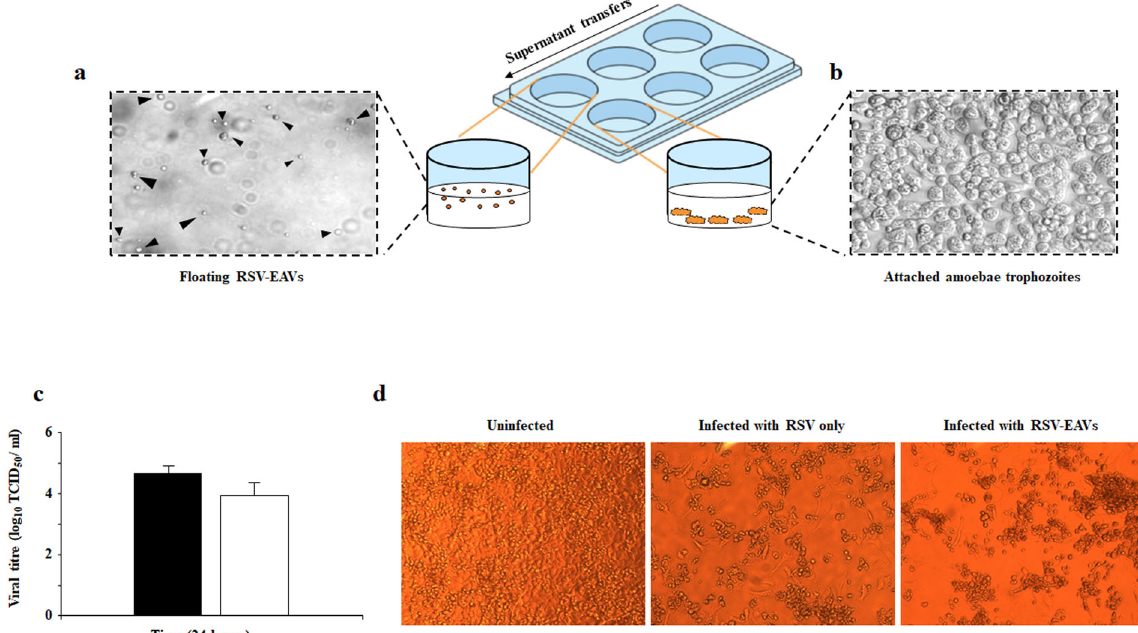
Fig. 3 RSV-EAVs isolation and infectivity assay. Micrographs (40x) of a Released extracellular amoebal-vesicles containing RSV and b Attached amoebae trophozoites. c Replication kinetics of the control RSV alone (black bar) and RSV-EAVs (white bar) analysed by TCID50 on Hela cells. Data are the mean ± SEM, n = 3 performed in triplicate. d Micrographs (20x) of cytopathic effect (CPE) induced by RSV-EAVs infection in Hela cells at 5 days